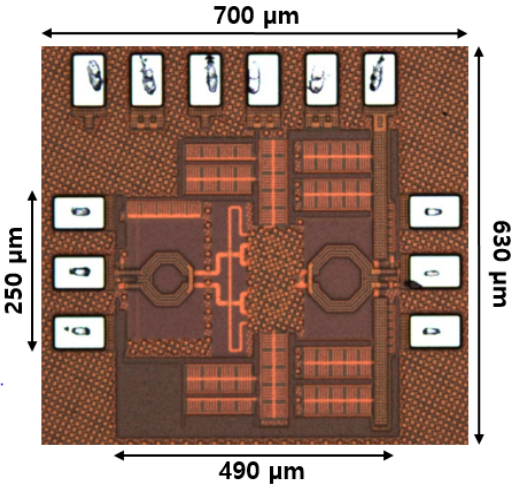
Figure 6. Chip microphotograph. Measured and simulated S-parameters are plotted in Figure 7a. The measured small signal gain is 14.6 dB and the input return loss is − 9.4 dB for 24 GHz. Figure 7b shows the measured power gain, output power, and power added efficiency (PAE) of the proposed PA with a 24 GHz 1-tone continuous wave (CW) signal. The large signal measurement results demonstrate 15.4 dB gain, saturated output power of 23.3 dBm, output 1-dB compression point of 20.8 dBm, and peak PAE of 31.3% at 24 GHz. The large signal performance versus different frequencies is shown in Figure 7c from 22 GHz to 28